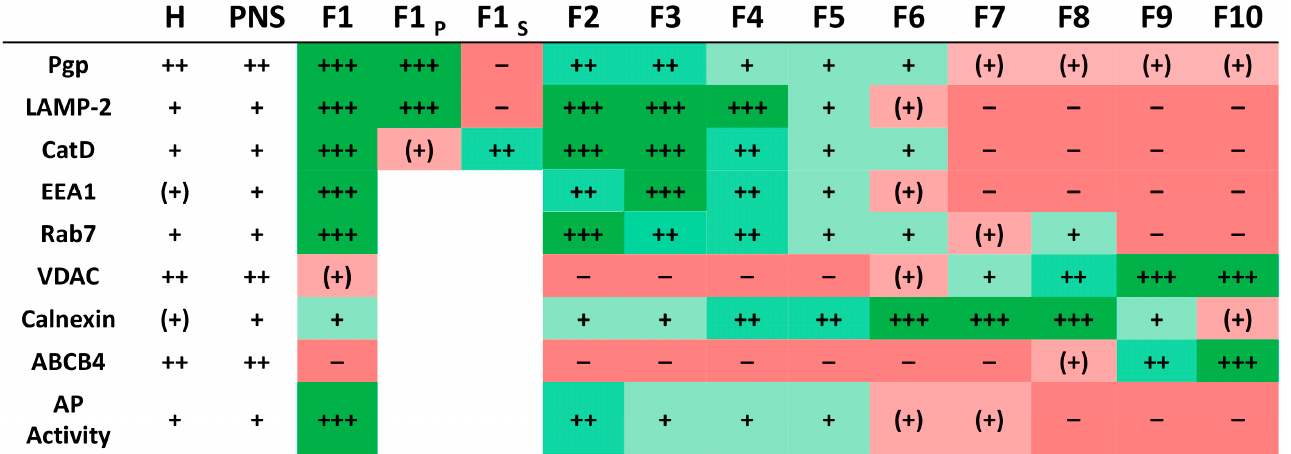
Figure 5. Overview of organelle marker distribution in the gradient fractions. Organelle marker and Pgp distribution in the gradient fractions (F1–10) according to high (+++), medium (++), low (+), or no ( − ) marker protein content in the respective fraction based on Western blot band intensities or acid phosphatase (AP) activity. Additionally, the Pgp protein level in the membrane enriched pellet (P) isolate and the luminal supernatant (S) resulting from endolysosomal subfractionation of gradient fraction (F) 1 are depicted. The organelle marker distribution is also highlighted by a color code from dark green (high marker content) to dark red (no marker localization). LAMP-2 (lysosomal associated membrane protein 2): endolysosomal marker; integral membrane protein, CatD (cathepsin D): endolysosomal luminal protease; EEA1 (early endosomal antigen 1): early endosomes; Rab7: late endosomal/endolysosomal marker; VDAC (voltage-dependent anion channel): mitochondrial marker; calnexin: ER marker; ABCB4: canalicular plasma membrane marker; AP: acid phosphatase (endolysosomal